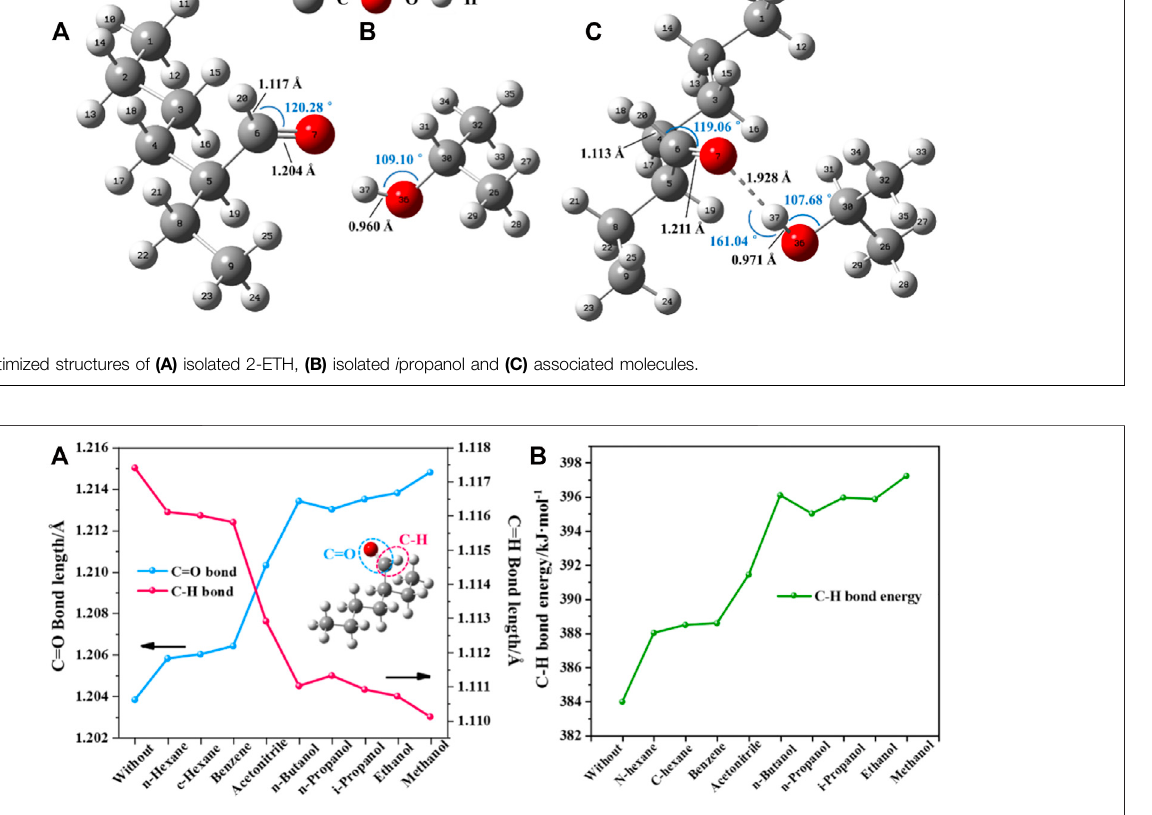
FIGURE 5 | Calculated (A) Molecule structure parameters and (B) C-H bond energy change of 2-ETH in different solvents.